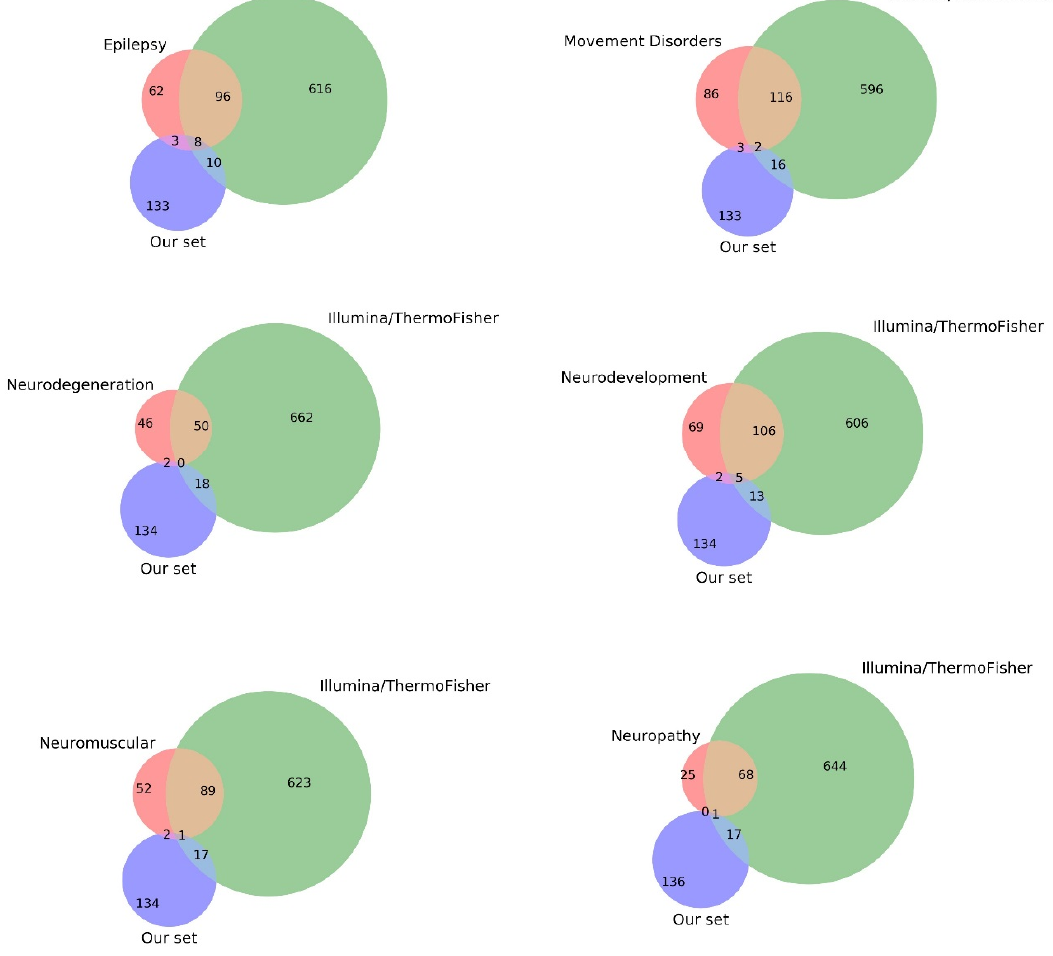
Figure 2. Venn diagrams of the overlapping of lists of genes, with lists of standard panels for target sequencing by Roche and Illumina/ThermoFisher.